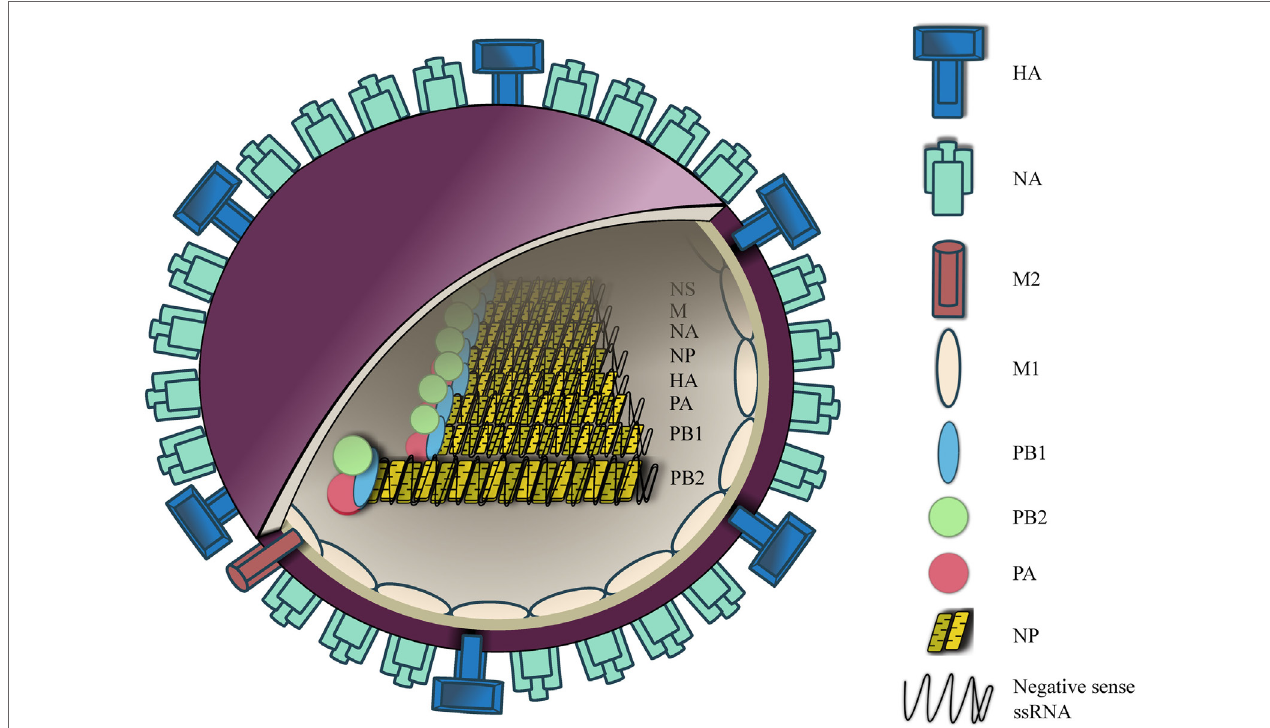
FigURe 1 | Influenza A virus (IAV) structure. IAV contains an outer membrane envelope with hemaglutinin (HA), neuraminidase (NA), and matrix 2 (M2) ion channels, and an inner M1 protein layer that encloses an eight segmented RNA genome. The RNA segments are folded into a helical hairpin structure with nucleoprotein, which are complexed with heterotrimeric RNA-dependent RNA polymerase [polymerase basic (PB1), PB2, and polymerase acidic (PA)].